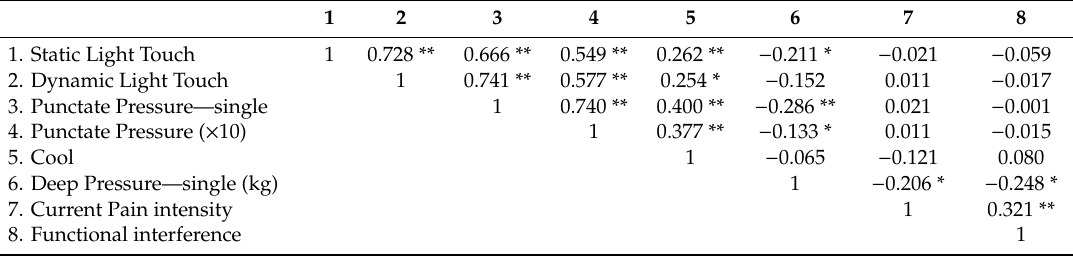
Table 5. Pearson correlations between cutaneous Coloured Analogue Scale responses and deep pressure pain threshold at the pain site, as well as pain outcomes variables (pain intensity and functional